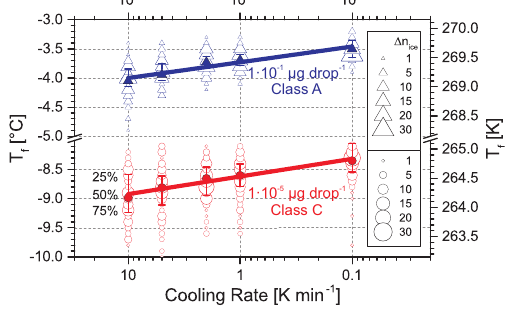
Figure 5. Freezing temperatures of water droplets containing Snomax ® at concentrations of 1 × 10 − 5 µgdrop − 1 (red) and 1 × 10 − 1 µgdrop − 1 (blue) as a function of experimental cooling rate. The number of nucleation events at individual temperatures is indicated by the size of the open symbols. Solid symbols indicate the median freezing temperature ( T f , 50 ), with error bars represent- ing the 25th and 75th percentiles. Solid lines are linear fits to the solid symbols; see